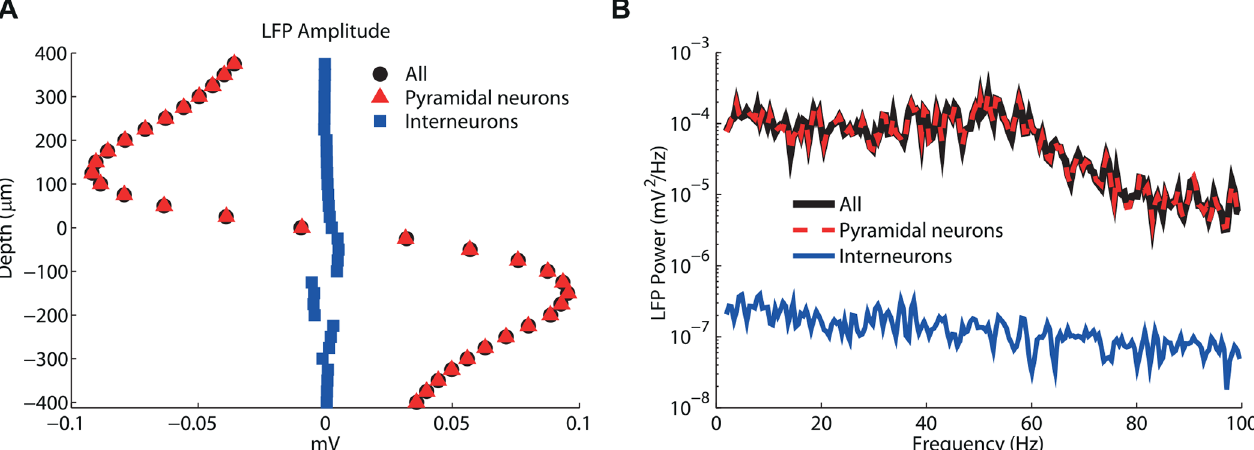
Fig 3. Contribution from individual neuron types to simulated LFP signal. Decomposition of LFP obtained in same conditions as Fig 2 into contributions from currents through the membrane of interneurons and pyramidal neurons. (A) Depth-resolved amplitude of LFP signal generated by all neurons (black), by the pyramidal neurons (red), and by the interneurons (blue). (B) Corresponding LFP power spectra for the three sets depicted in (A) at a depth of 100 μ m.